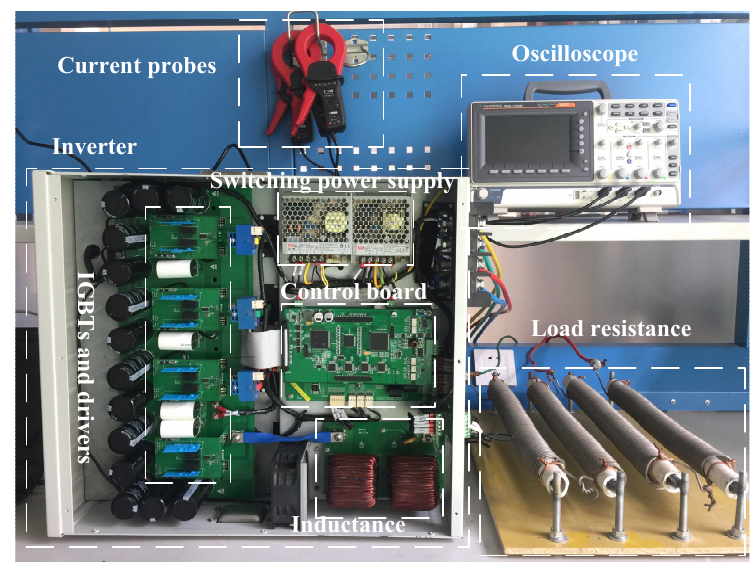
Figure 5. Photograph of the experimental test rig. Table 1. Parameters for the system.